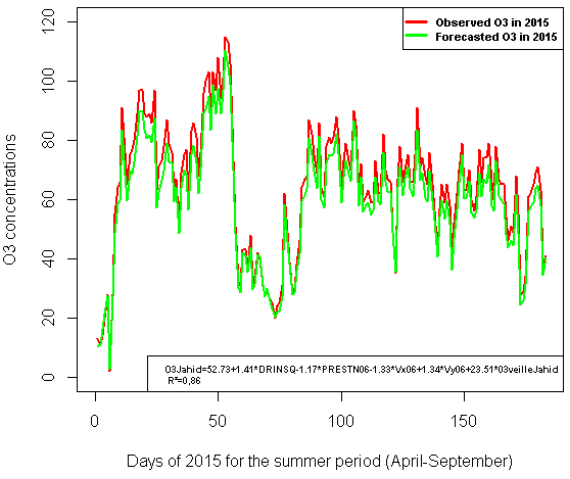
Figure 7. Comparison between observed and forecasted O 3